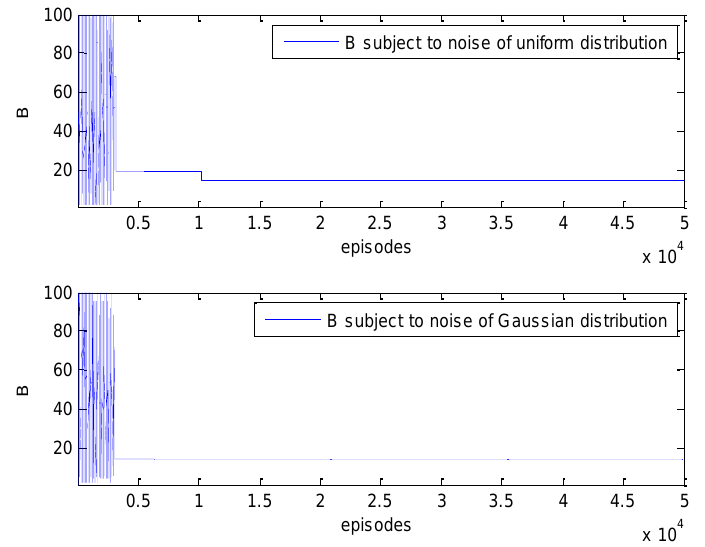
Figure 5. The episode training process of viscous damping coefficient (B was predetermined as 15).